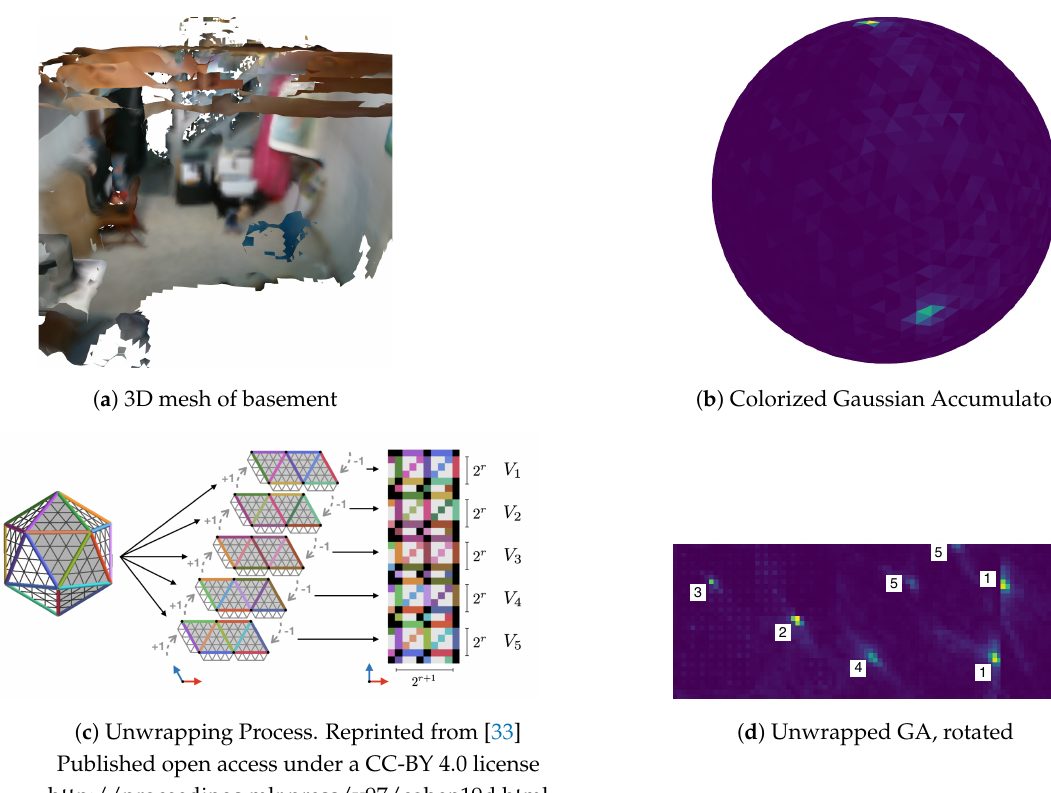
Figure 12. ( a ) Example basement scene mesh; ( b ) Mesh triangle normals are integrated into the Gaussian Accumulator and colorized showing peaks for the floor and walls; ( c ) Overview of unwrapping a refined icosahedron into a 2D image. Five overlapping charts are stitched together to create a grid. Padding between charts is accomplished by copying adjoining chart neighbors using the unwrapping process and its illustration from [33]; ( d ) Unwrapped Gaussian Accumulator creating a 2D image used for peak detection. White boxes indicate detected peaks. Duplicate peaks are merged (1 & 5) with agglomerative hierarchical